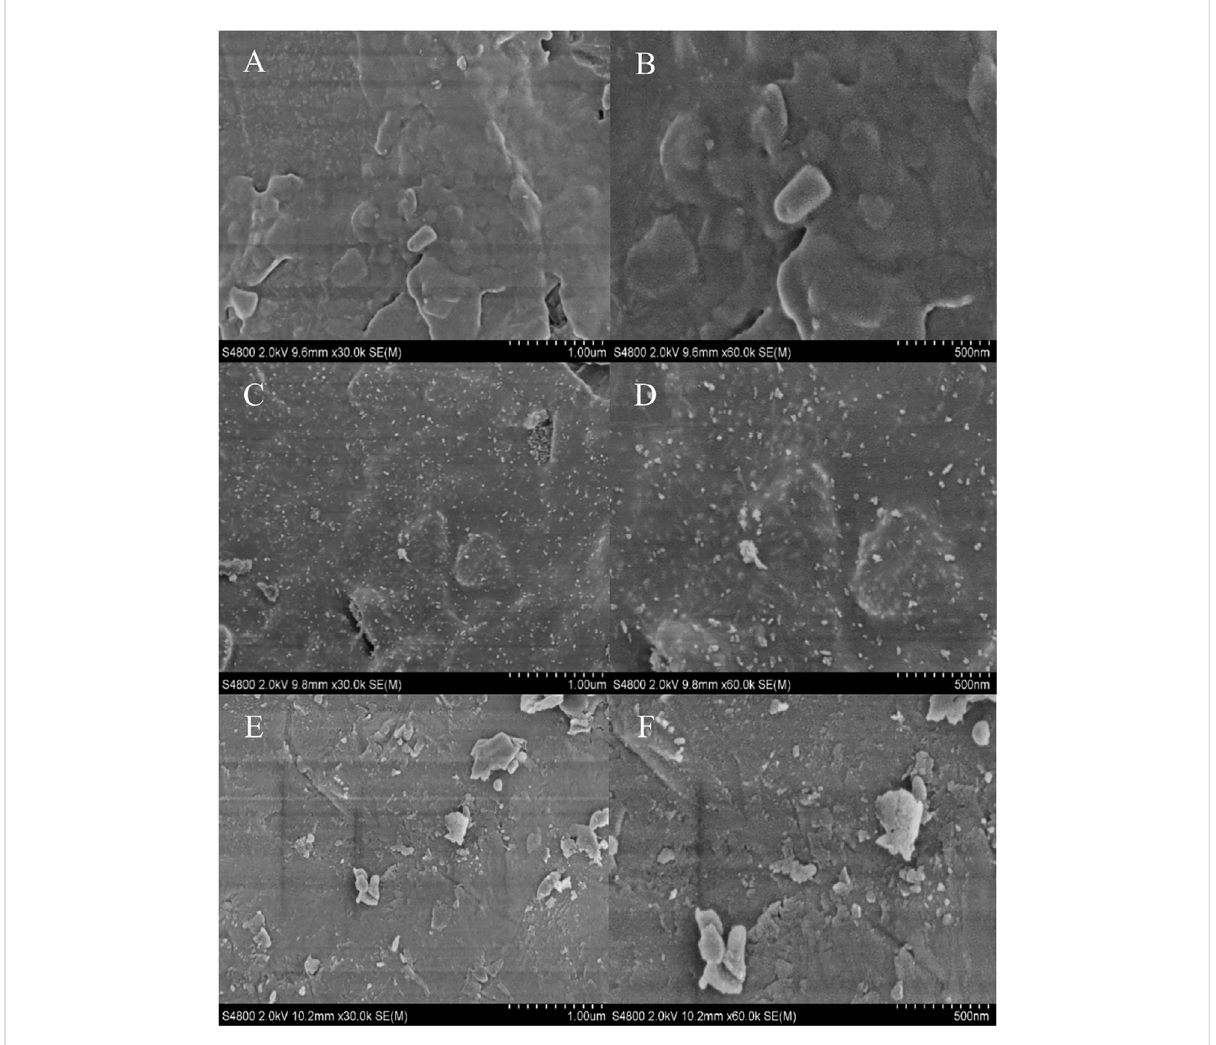
FIGURE 6 Comparison of scanning electron microscope before and after phosphorus adsorption (A) coal ash ceramsite unloaded with nano-iron (1 μ m); (B) coalashceramsiteunloadedwithnano-iron(500 nm); (C) coalashceramsiteloadedwithnano-ironbeforetheadsorptionofphosphorus(1 μ m); (D) coal ash ceramsite loaded with nano-iron before the adsorption of phosphorus (500 nm); (E) coal ash ceramsite loaded with nano-iron after the adsorption of phosphorus (1 μ m); (F) coal ash ceramsite loaded with nano-iron after the adsorption of phosphorus (500